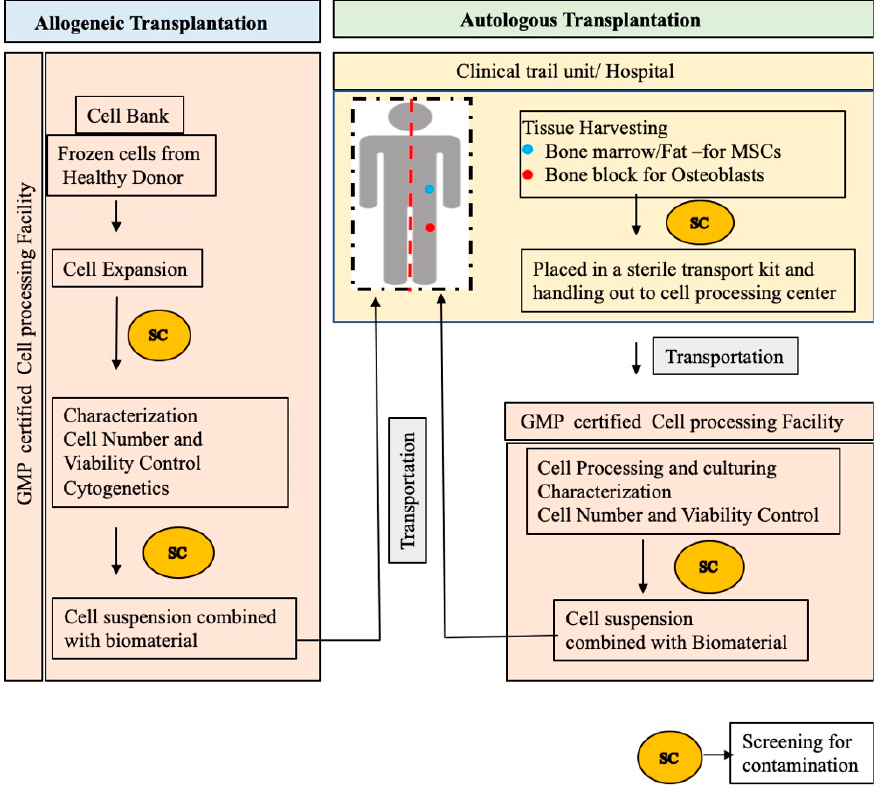
Figure 3. Schematic outline of standard procedure in preparing cell-scaffold constructs for bone regeneration.